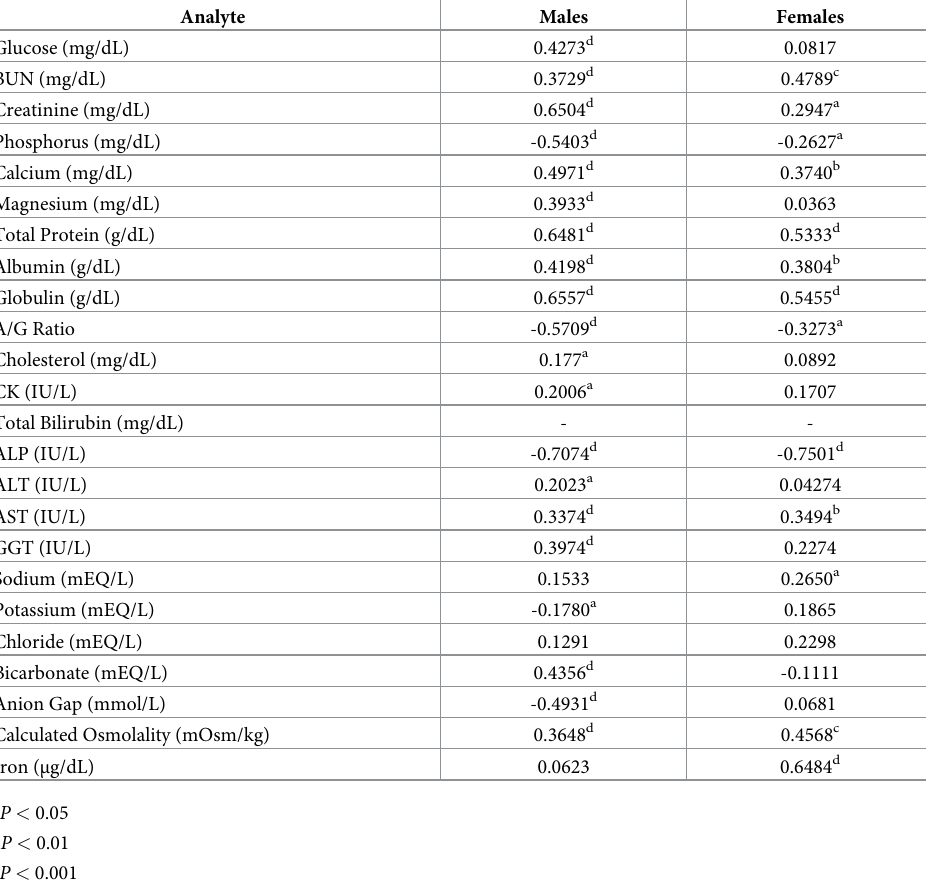
Table 5. Spearman correlation (r) of serum biochemistry parameters with age in male and female Dunkin Hartley guinea